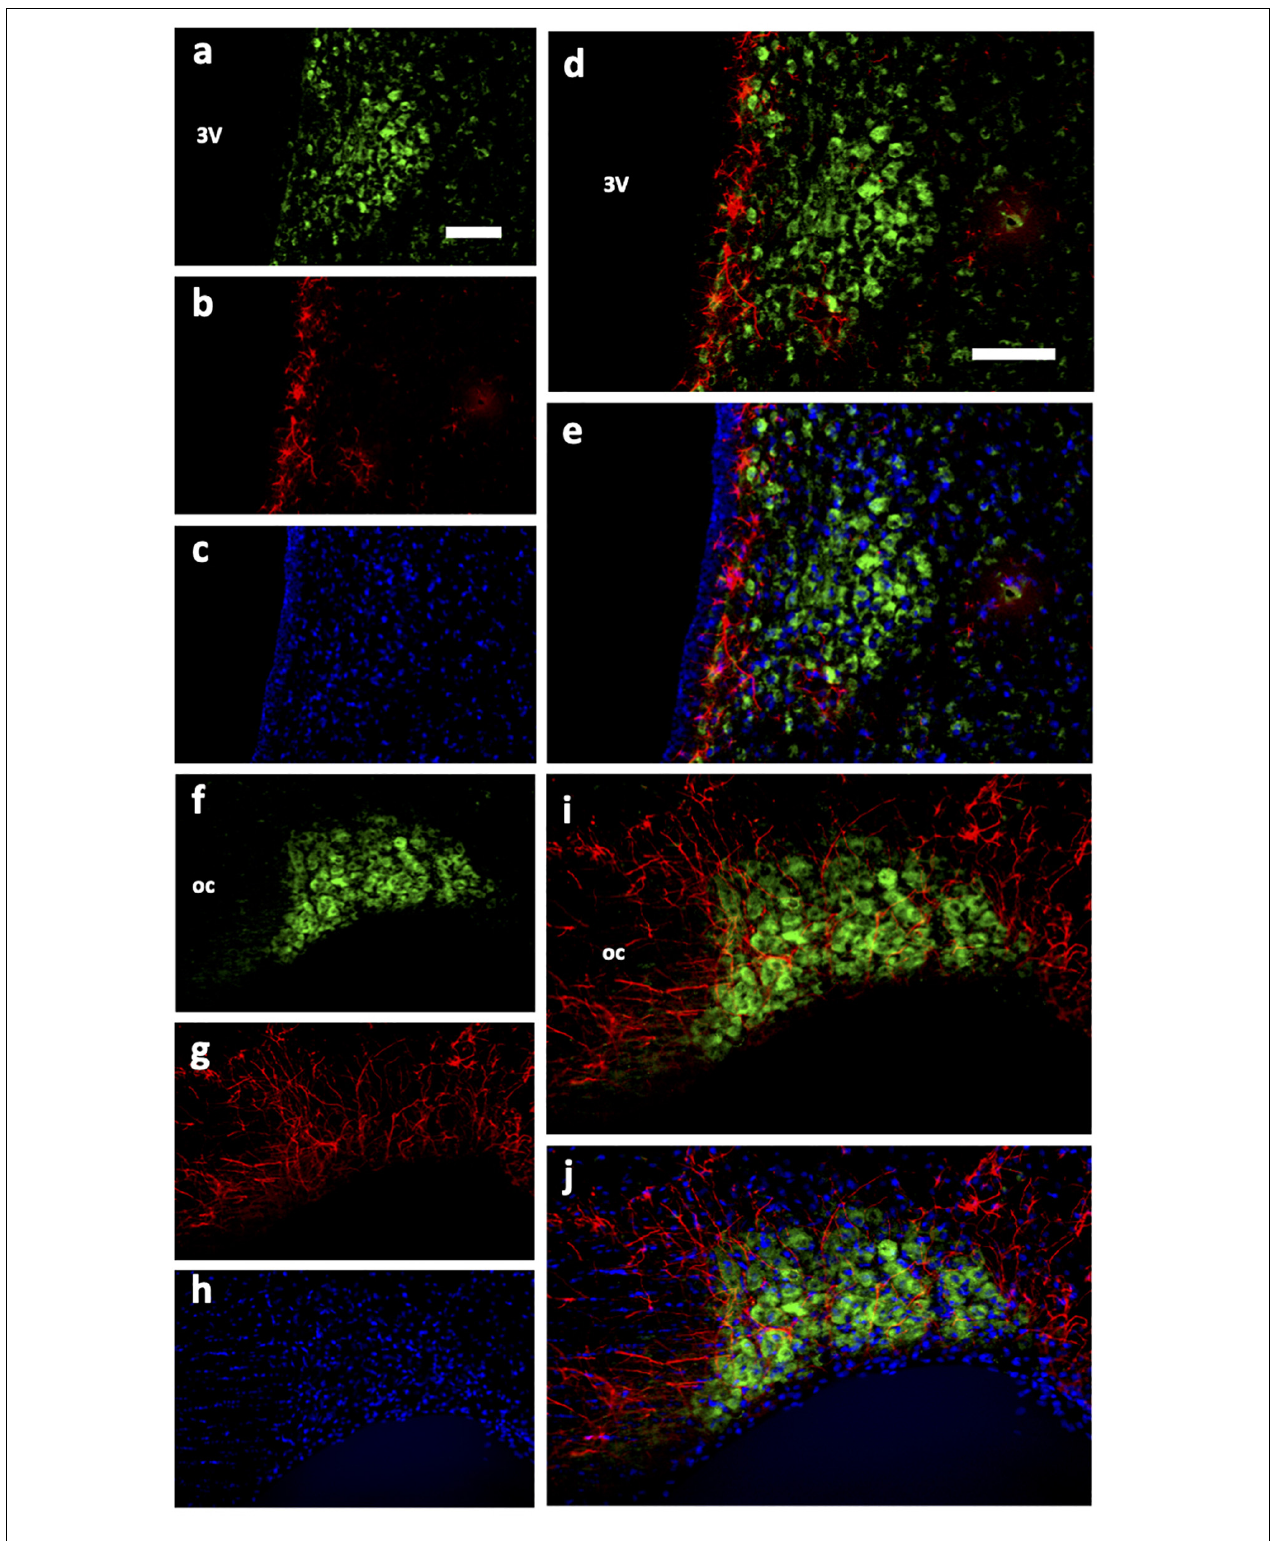
FIGURE 5 | Immunohistochemical analysis of Urocortin expression with glial cells in PVN and SON. (a,f) Ucn. (b,g) GFAP. (c,h) DAPI. (d,i) Ucn + GFAP. (e,j) Ucn + GFAP + DAPI. Ucn, Urocortin; GFAP, glial fibrillary acidic protein; DAPI, 4 (cid:48) ,6-diamidino-2-phenylindole. 3V, Third Ventricle; oc, optic chiasm. Scale Bar = 100 µ